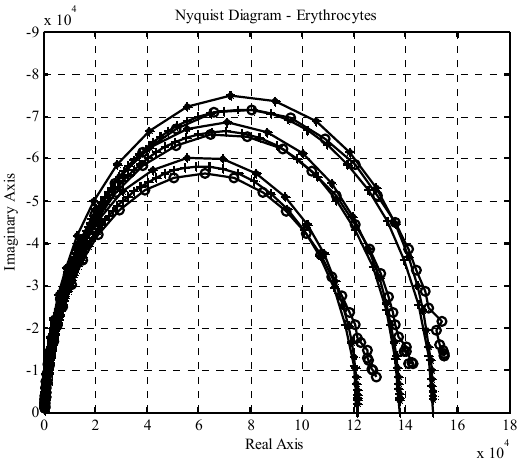
Fig. 8: Nyquist diagram for erythrocytes showing reactance as a function of